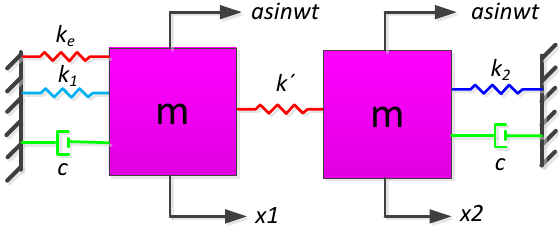
Figure 1. The model of the non-ideal TFG with the match stiffness.